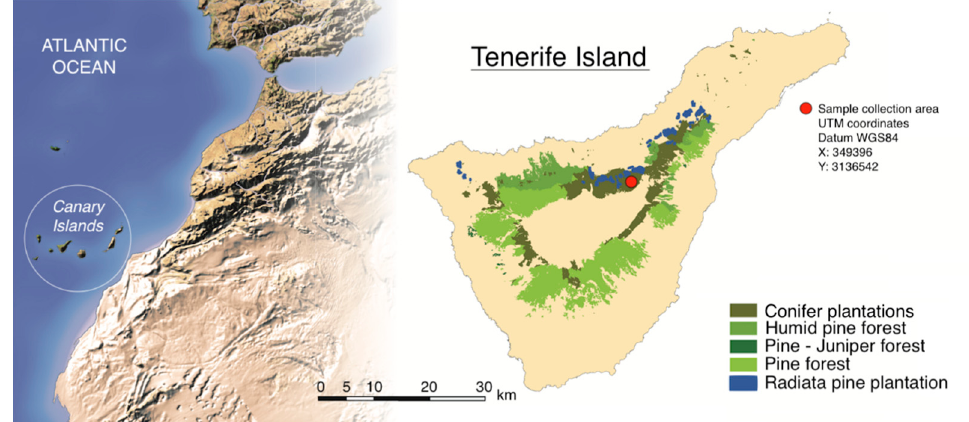
Figure 1. Distribution of pine forests on the island of Tenerife. Based on a map from Área de Sostenibilidad, Medio Ambiente, Aguas y Seguridad, Cabildo de Tenerife.